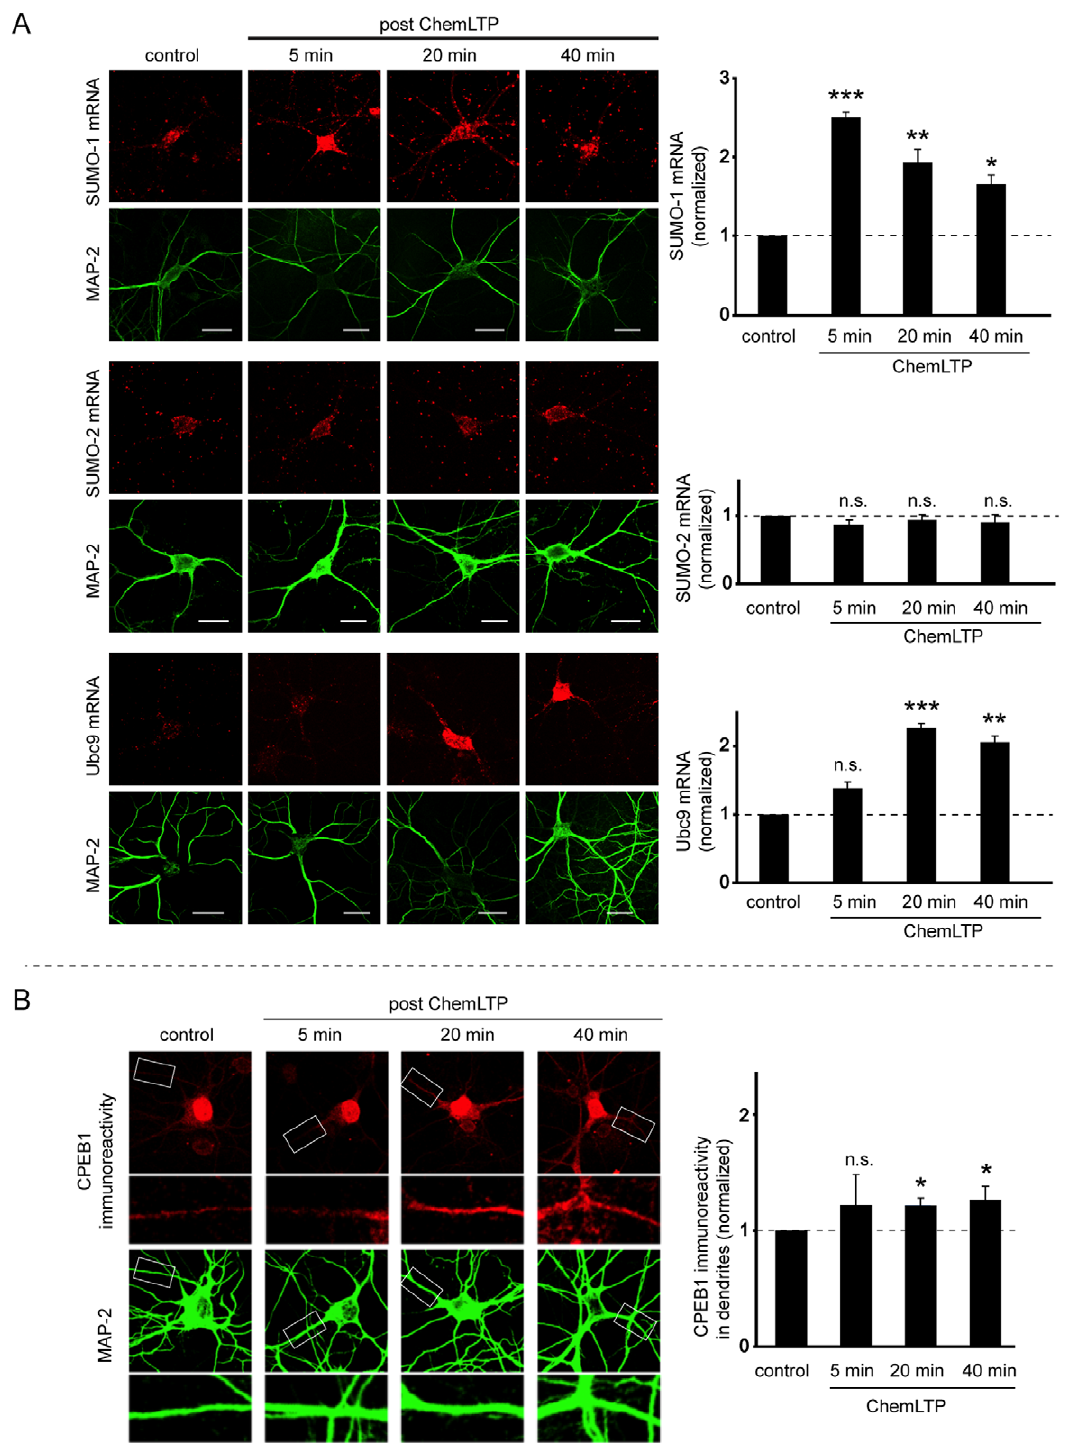
Figure 3. ChemLTP increases SUMO-1 and Ubc9 mRNA. A) Fluorescent in situ hybridization using cRNA probes for SUMO-1, SUMO-2 and Ubc9 (red) in hippocampal neurons co-stained with the dendritic marker MAP-2 (green). ChemLTP increased levels of SUMO-1 and Ubc9 but not SUMO-2 mRNA in soma and dendrites. Mean fluoresence intensity was quantified in at least 3 independent experiments with 10 neurons per condition and 3 ROIs per neuron using ImageJ. B) ChemLTP increases levels of the mRNA binding protein CPEB1 (red) in hippocampal cultured neurons co- immunostained with MAP2 (green). Three independent experiments with 8 neurons per condition and 4 ROIs per neuron were quantified using JACoP plugin in ImageJ. Statistical significance was determined using ANOVA *p , 0.02; **p , 0.005. Scale bars – 20 m m.